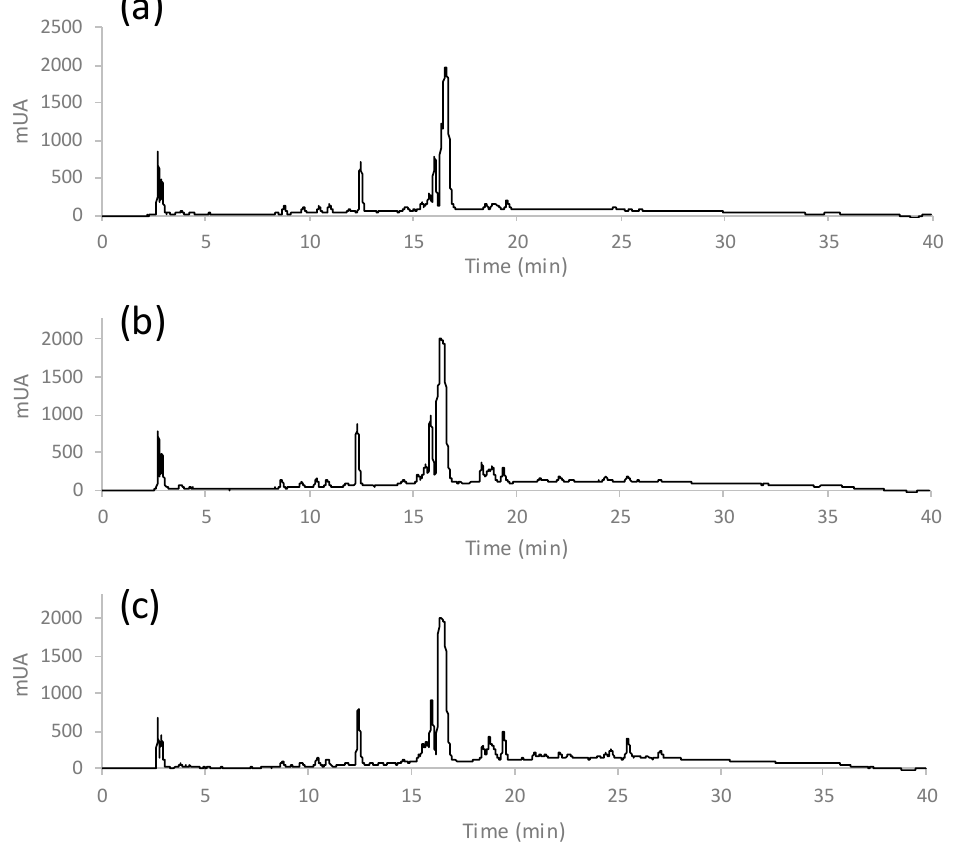
Figure 2. Non-targeted high-performance liquid chromatography with ultraviolet detection (HPLC-UV) fingerprints at 280 nm of three coffees of the first set of samples. ( a ) Arabica coffee from Ethiopia, ( b ) Arabica-Robusta mixture coffee from India, ( c ) Robusta coffee from Uganda.